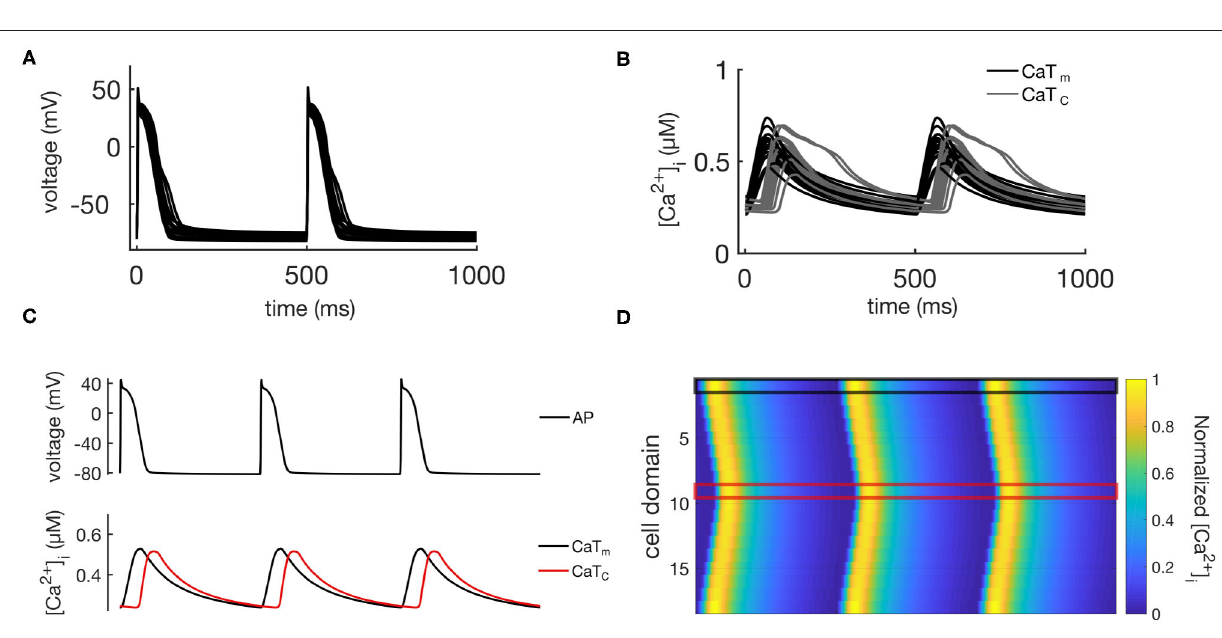
FIGURE 2 | Illustration of the behavior of the control population. (A) Shows APs for all 16 models, while the corresponding CaTs from the central and membrane domains are shown in (B) . (C) Shows the same data for a single representative model, while (D) shows spatio-temporal plots of the calcium propagation for the same